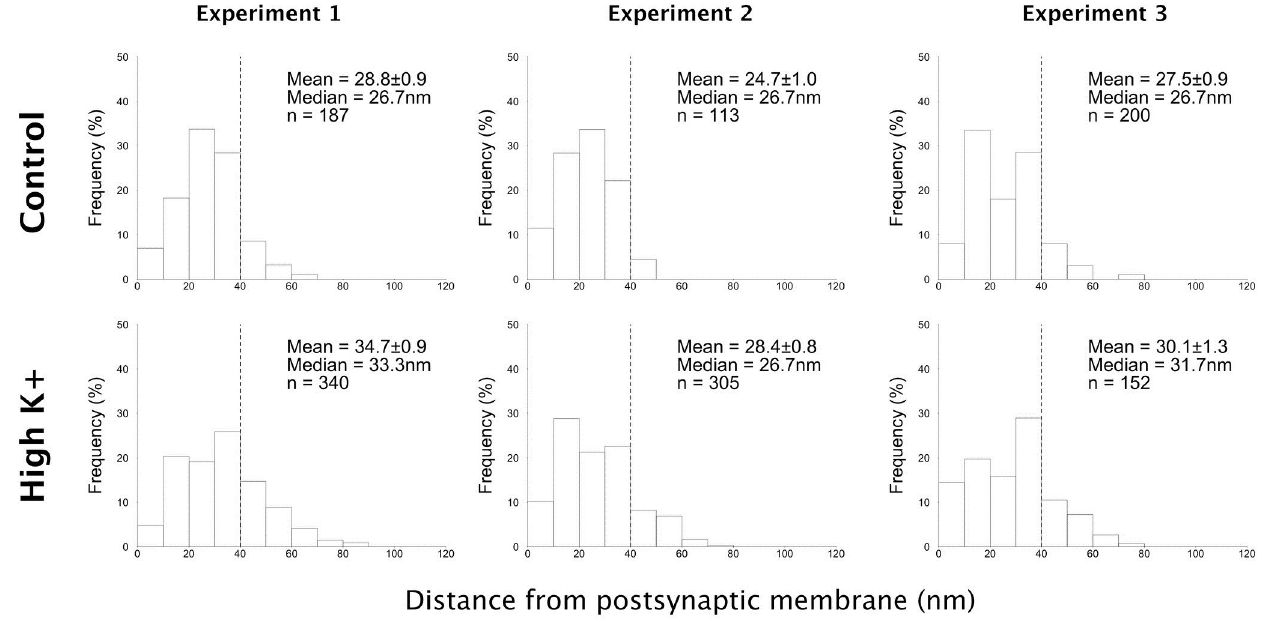
Fig 4. Distribution of Densin label within the PSD. Distances of gold particles from the postsynaptic membrane were measured in three experiments. Histograms show the percentage of label in consecutive laminar layers (10 nm bins). Under basal (control) conditions 90% of densin label is confined within the PSD core (40 nm from the postsynaptic membrane, marked by a dashed line on histograms). Following depolarization with high K + (90 mM for 2 min) a slight shift of label towards the PSD pallium (40–120 nm from the postsynaptic membrane) was observed, with 77% of label remaining within the PSD core.